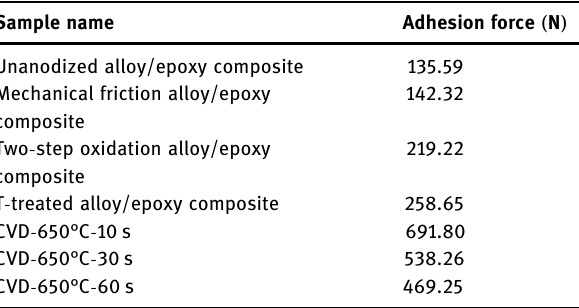
Table 2: Test results for the adhesion of metal - resin composite